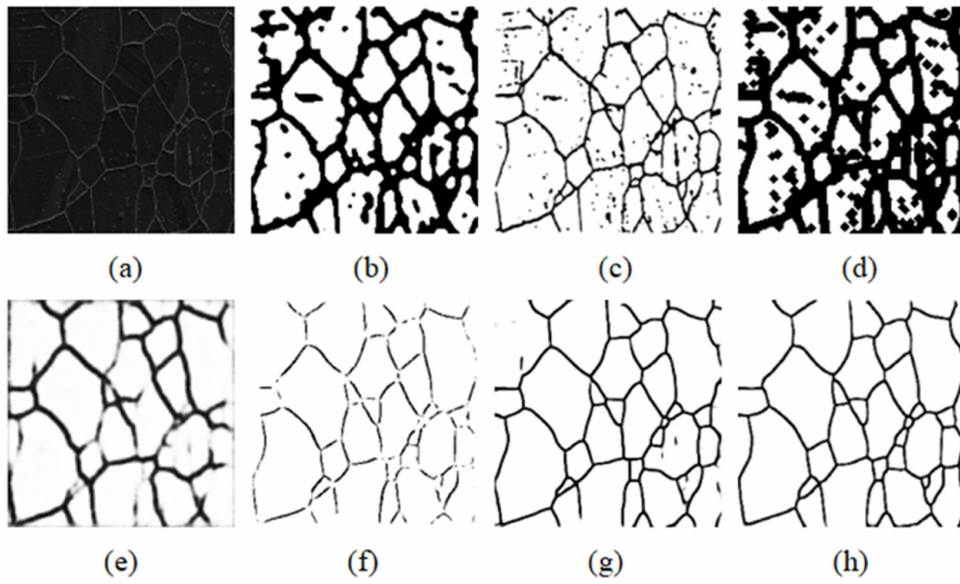
Figure 6. The segmentation result of different segmentation methods. ( a ) The original image; ( b ) Morphological methods; ( c ) Canny algorithm; ( d ) Watershed algorithms; ( e ) Mipar; ( f ) U-Net; ( g ) U-Net++; ( h ) improved